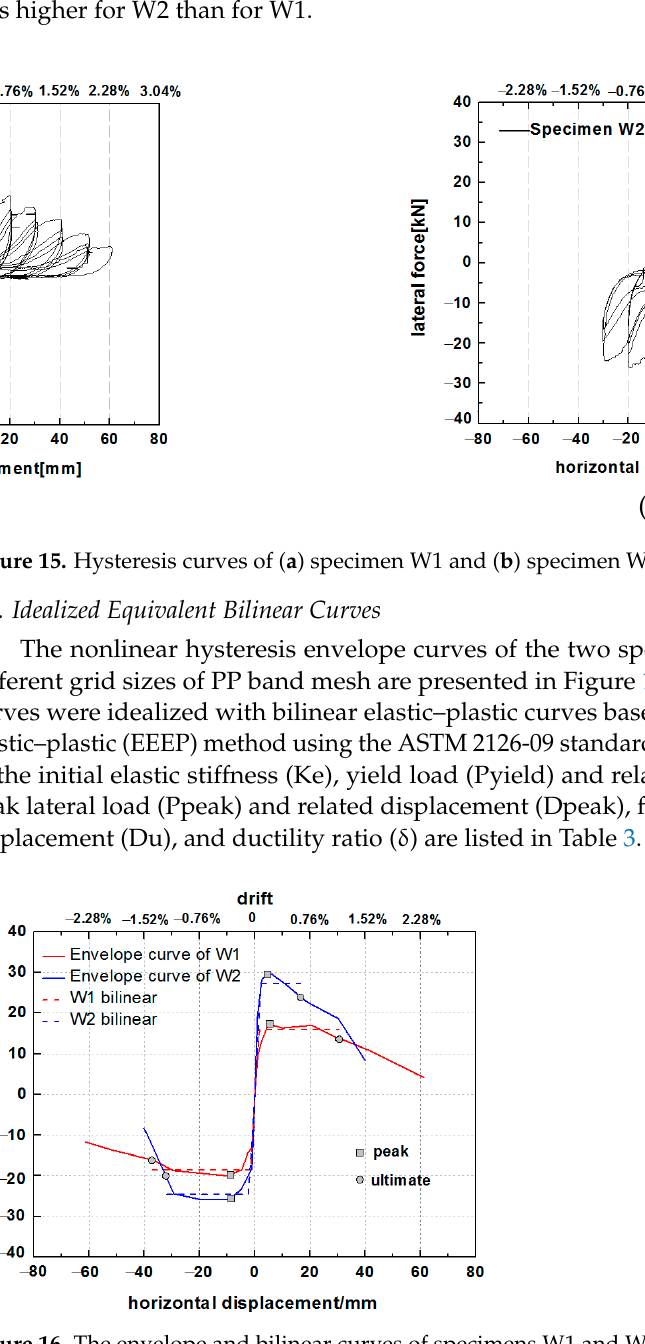
Figure 16. The envelope and bilinear curves of specimens W1 and W2.